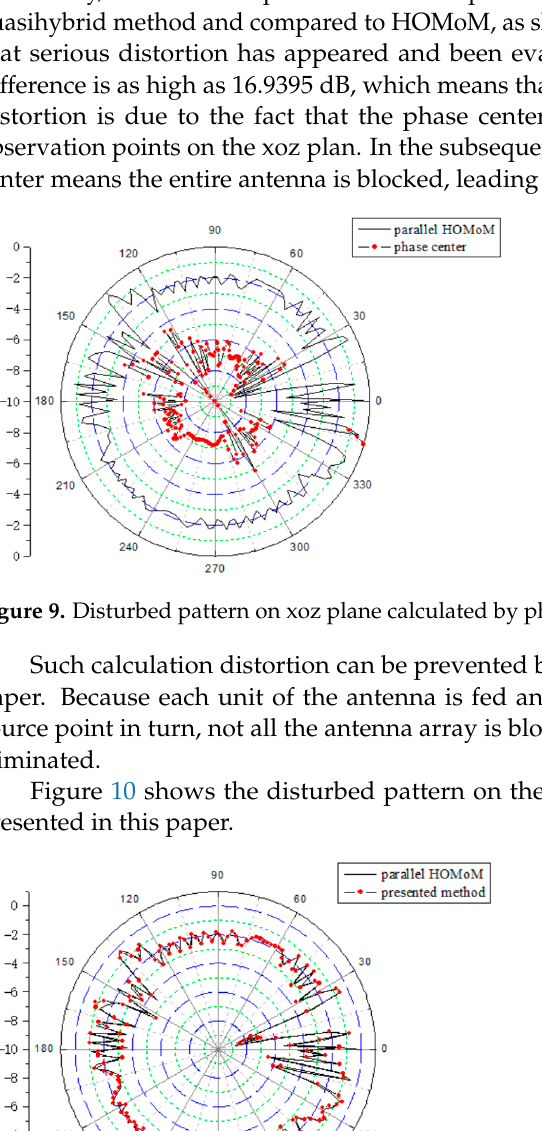
Figure 8. A T-shaped structure.